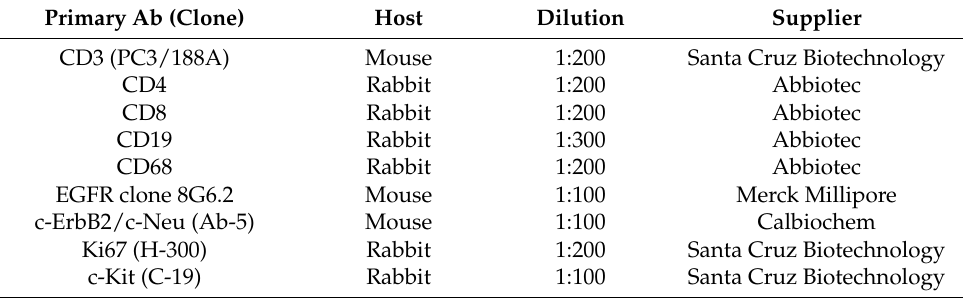
Table 1. Antibodies used in